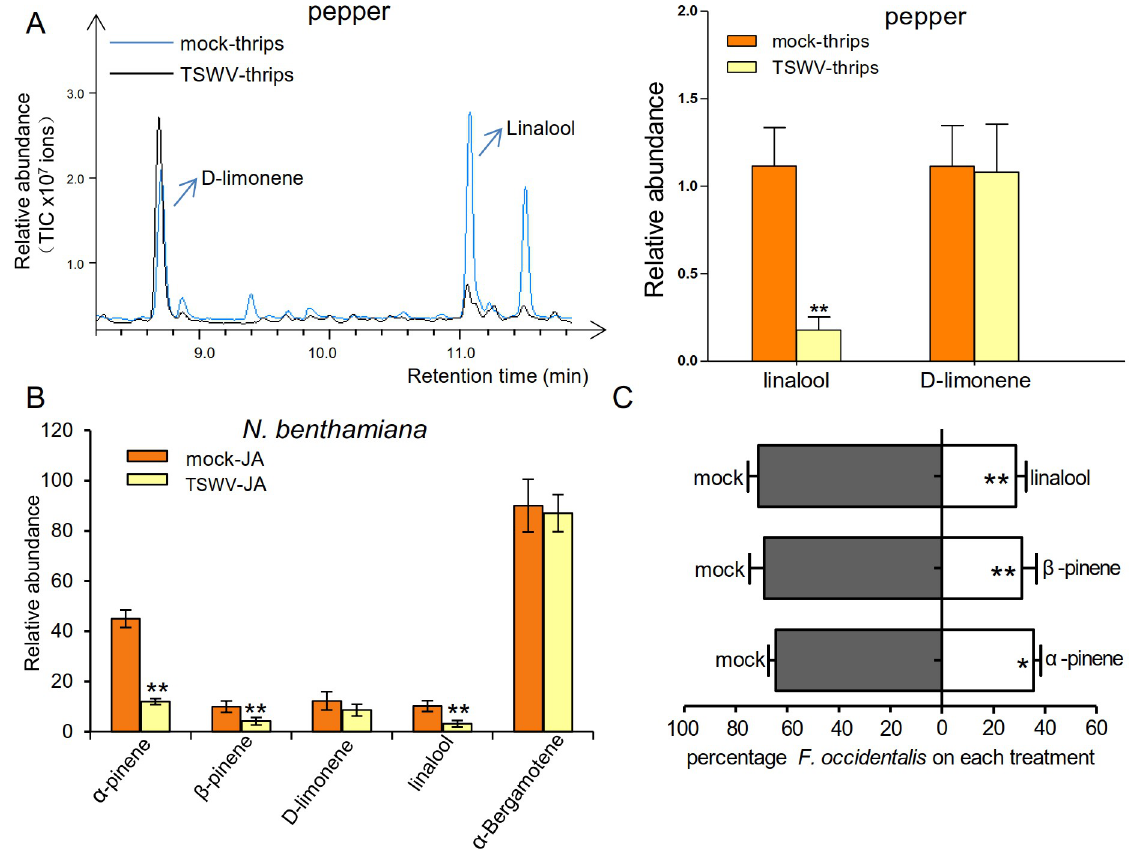
Fig 2. TSWV infection increases attractiveness to the thrips vector in a terpene-dependent manner. (A) Representative GC/MS ion chromatograms of the headspace volatile compounds of control (mock-thrips) and TSWV-infected peppers (TSWV-thrips) after thrips infestation for 6 h. The peaks of specific products are marked with arrows in the left panel. Relative abundance of terpenes emitted after thrips infestation are showed in the right panel. Values are means + SE, n = 4. �� P < 0.01, Student’s t -test. (B) Terpenes emitted by N . benthamiana after TSWV infection (under MeJA treatment). Values are mean relative amounts (percentage of internal standard peak area) ± SE, n = 4. �� P < 0.01, Student’s t -test. (C) Thrips preference (as percentage recaptured WFT out of 50 released) on the pure monoterpenes (linalool, α - pinene, β -pinene) and solvent control (n-hexane) in a two-choice assay. Data are mean percentages + SE, n = 6. � P < 0.05 �� P < 0.01, Wilcoxon matched pairs